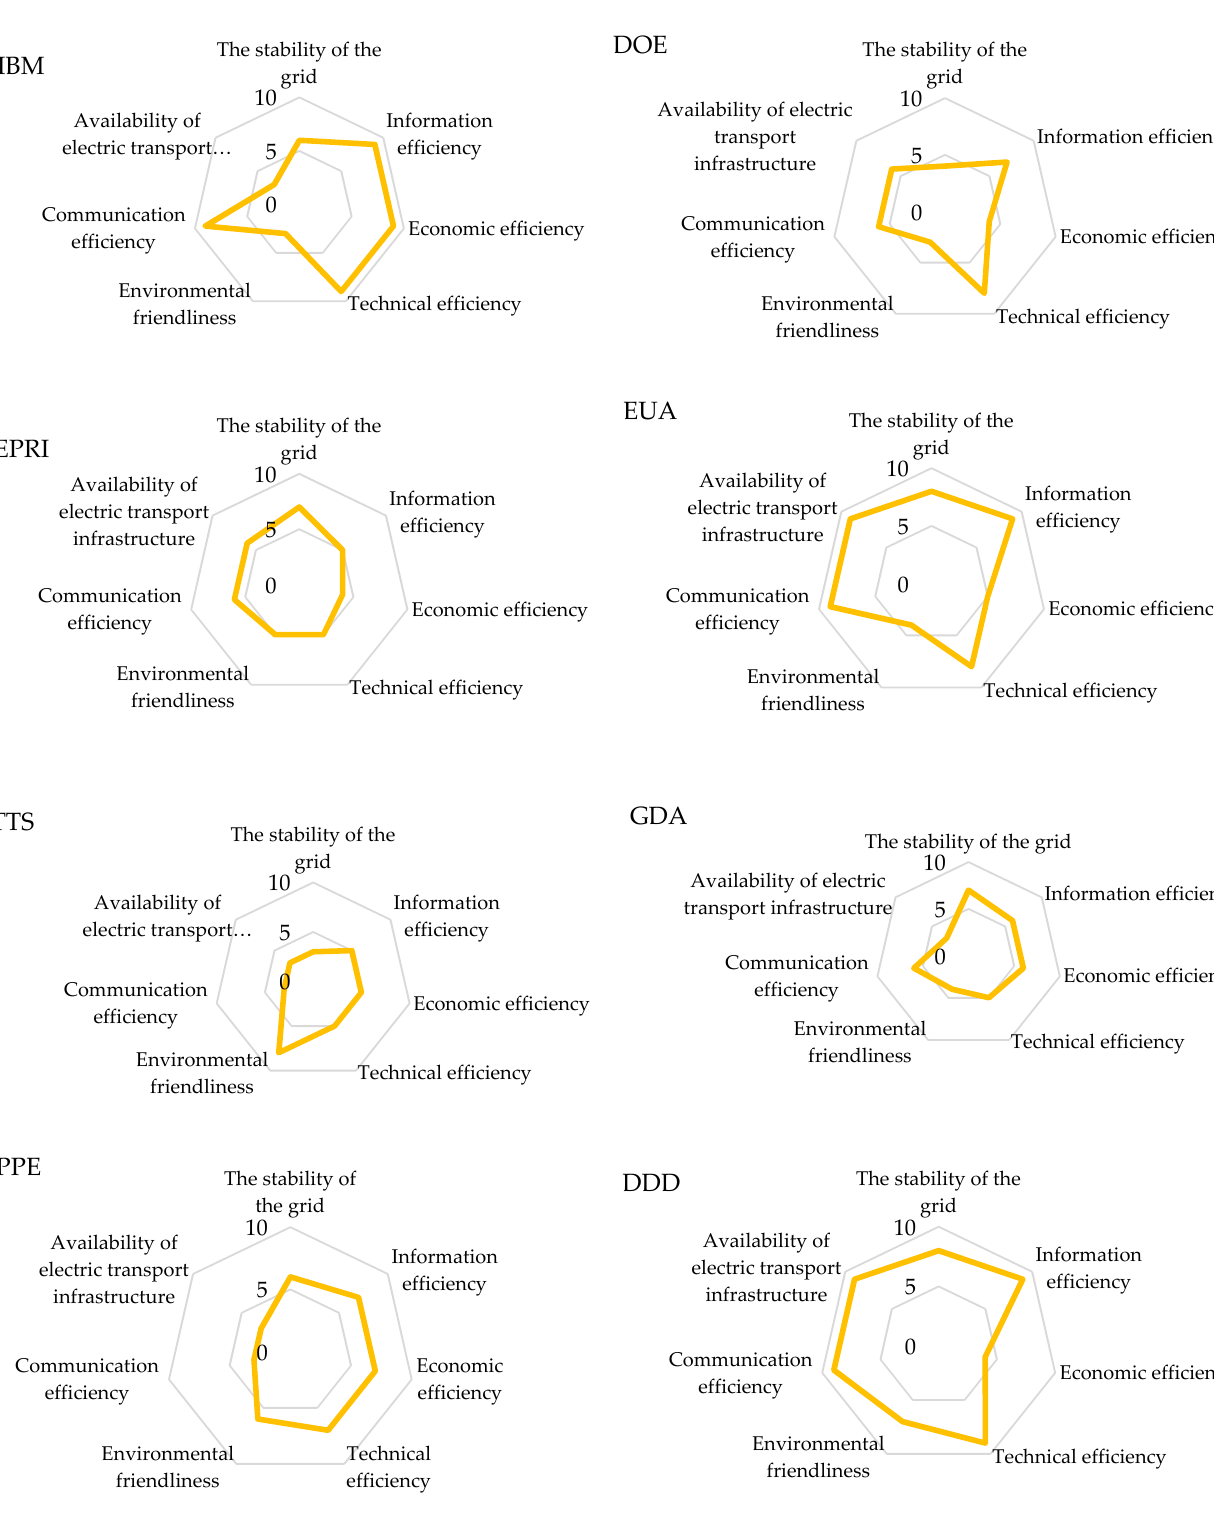
Figure 7. Profiles of comprehensive assessment systems.